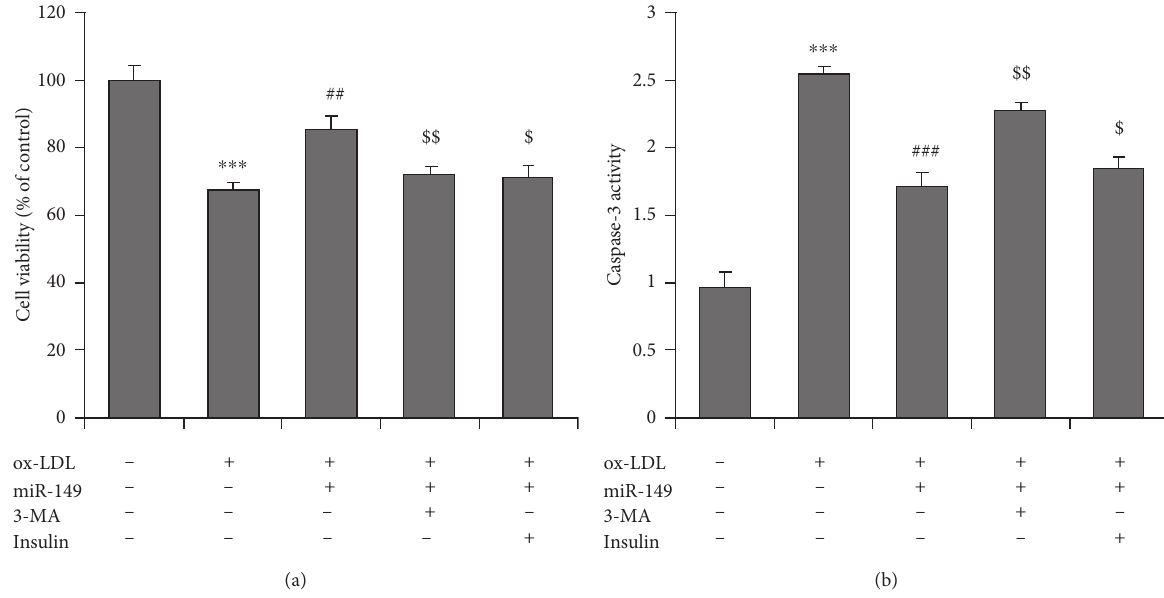
Figure 4: Enhanced autophagy and suppressed Akt/mTOR mediate the protective effects of miR-149 mimics. The inhibitor of autophagy (3- methyladenine, 3-MA, 100 μ m) and activator of Akt/mTOR pathway (insulin, 200nm) were used. (a) Cell viability of HUVECs. (b) Caspase- 3 activity of HUVECs. ∗∗∗ P < 0 . 001 vs. control group; ## P < 0 . 01 and ### P < 0 . 001 vs. ox-LDL group; $ P < 0 . 05 and $$ P < 0 . 01 vs. miR-149